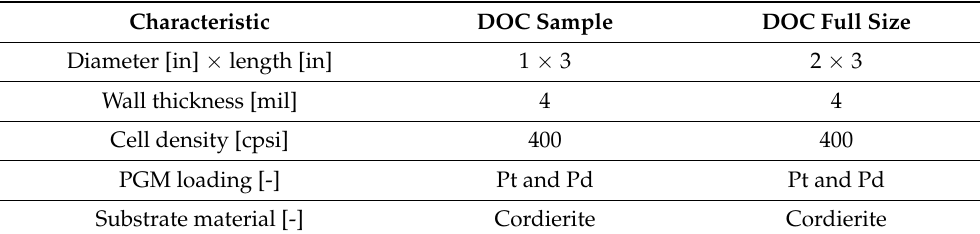
Table 6. Characteristics of reactor scale DOC sample and DOC full-size catalyst.